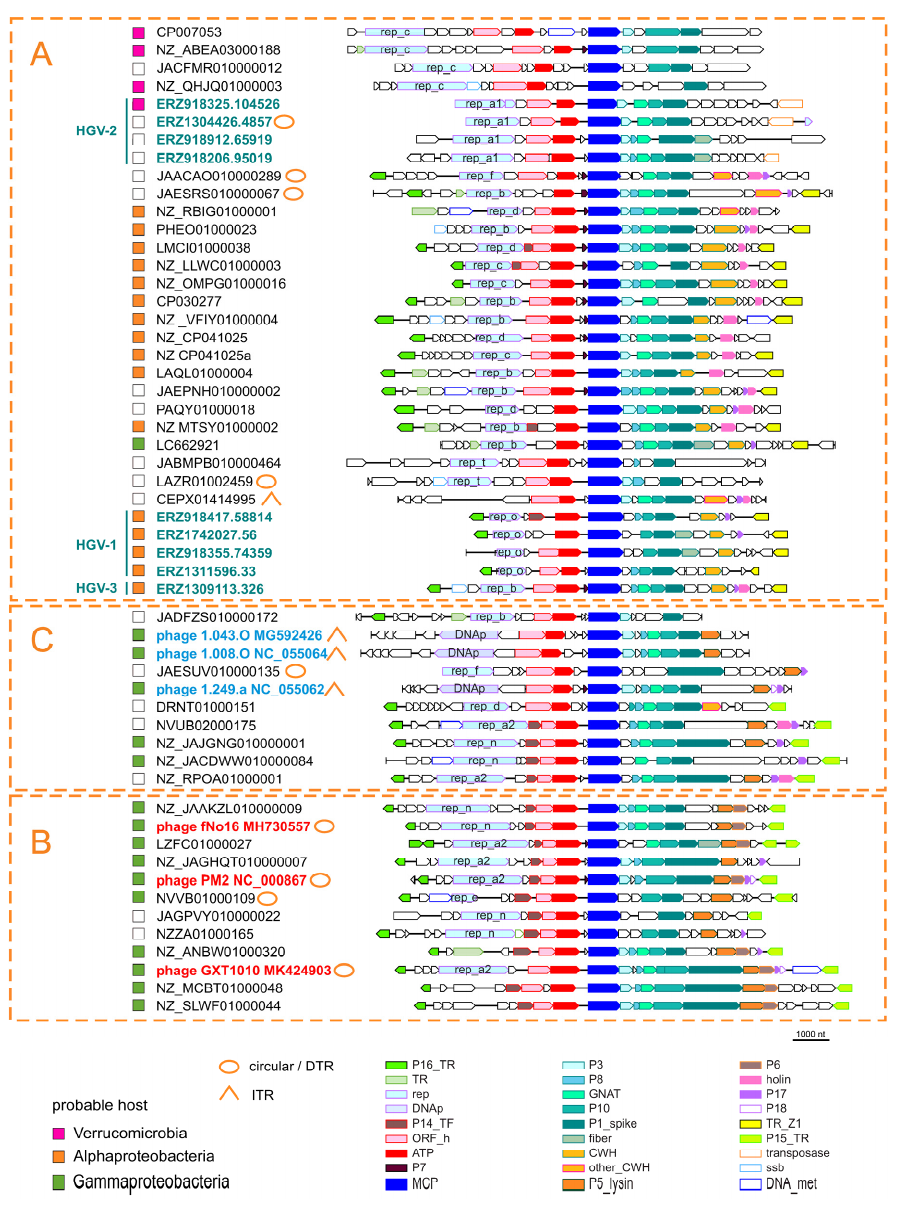
Figure 2. Phylogenetic tree of the MCP of viruses of the orfer Vinavirales . Branch color indicates predicted hosts: blue, betaproteobacteria; magenta, Verrucomicrobia. Human gut sequences, cultured Corticoviridae and Autolykiviridae are labeled (teal, red, and blue circles, respectively). Circles mark 54 representative genomes/contigs selected for further analysis. The 5 major clades are denoted A to E, and the bootstrap support values are indicated for each of these clades. The 3 groups of MCPs from human gut microbiomes are denoted HGV1-3. The branches leading to the groups HGV1-3 all had bootstrap support values of 100 and are marked with black diamonds.